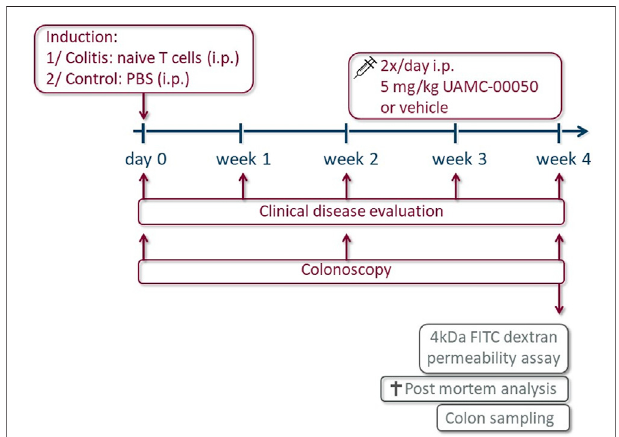
FIGURE 1 | Overview of the experimental design. On day 0, mice receivedanintraperitoneal(i.p.)administrationwithnaiveTcells(colitis)orPBS (control). The clinical disease score was evaluated every week and a colonoscopy was performed every other week for 4 weeks. From week 2onwards,animalswereinjectedi.p.withtheserineproteaseinhibitorUAMC- 00050 or vehicle 2x/d in a dose of 5 mg/kg. Final experiments were conducted after 4 weeks: intestinal permeability was determined by 4 kDa FITC-dextran and after sacri fi ce, a post-mortem analysis was executed to evaluate the in fl ammatory parameters and colon sampling was performed for the determination of cytokines via CBA and transcription factors, PARs and tight junctions via